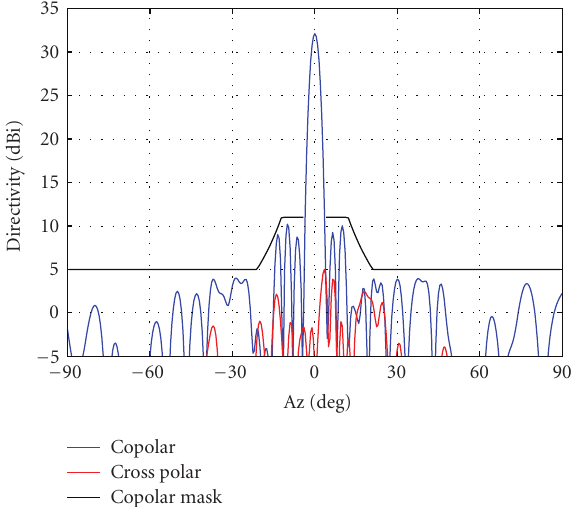
Figure 17: Azimuth Rx Antenna Pattern at 11.7 GHz, considering a 30 o elevation pointing over the horizon.